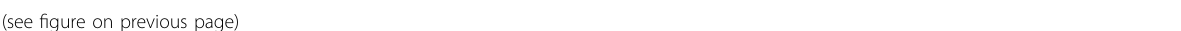
Fig. 1 XBP1 is involved in the crosstalk between mitochondrial damage and ERS in renal IRI. A Mitochondrial damage and severe ERS occurred simultaneously. TEM analysis revealed mitochondrial swelling, mitochondrial cristae and membrane disappearance, as well as the obvious swelling and vacuolization of ER and detachment of ribosomes from rough ER in IRI group. Normal ER is denoted by red arrows, swelling ER is represented by orange arrows, and swelling mitochondria is indicated by white arrows. Scale bar = 1 μ m; ×7000 magni fi cation. B IRI signi fi cantly elevated the levels of ROS in IRI group compared to sham group. DHE staining; ×400 magni fi cation; scale bar = 50 μ m. ** P < 0.01 vs. sham group ( n = 6). C The expression of ATM and P53 were raised in IRI group than in sham group. Immunohistochemistry; ×400 magni fi cation; scale bar = 50 μ m. ** P < 0.01 vs. sham group ( n = 6). D The number of apoptotic cells was higher in IRI group than in sham group. TUNEL staining; ×400 magni fi cation; scale bar = 50 μ m. ** P < 0.01 vs. sham group ( n = 6). E The fold changes in the expression of ERS-related molecules in the renal tissues after IRI. The expression levels of BiP, XBP1u, XBP1s, and HRD1 were measured by western blotting. Compared to sham group, the expression levels of ERS-related molecules were all increased in IRI group, especially XBP1s. ** P < 0.01 vs. sham group ( n =